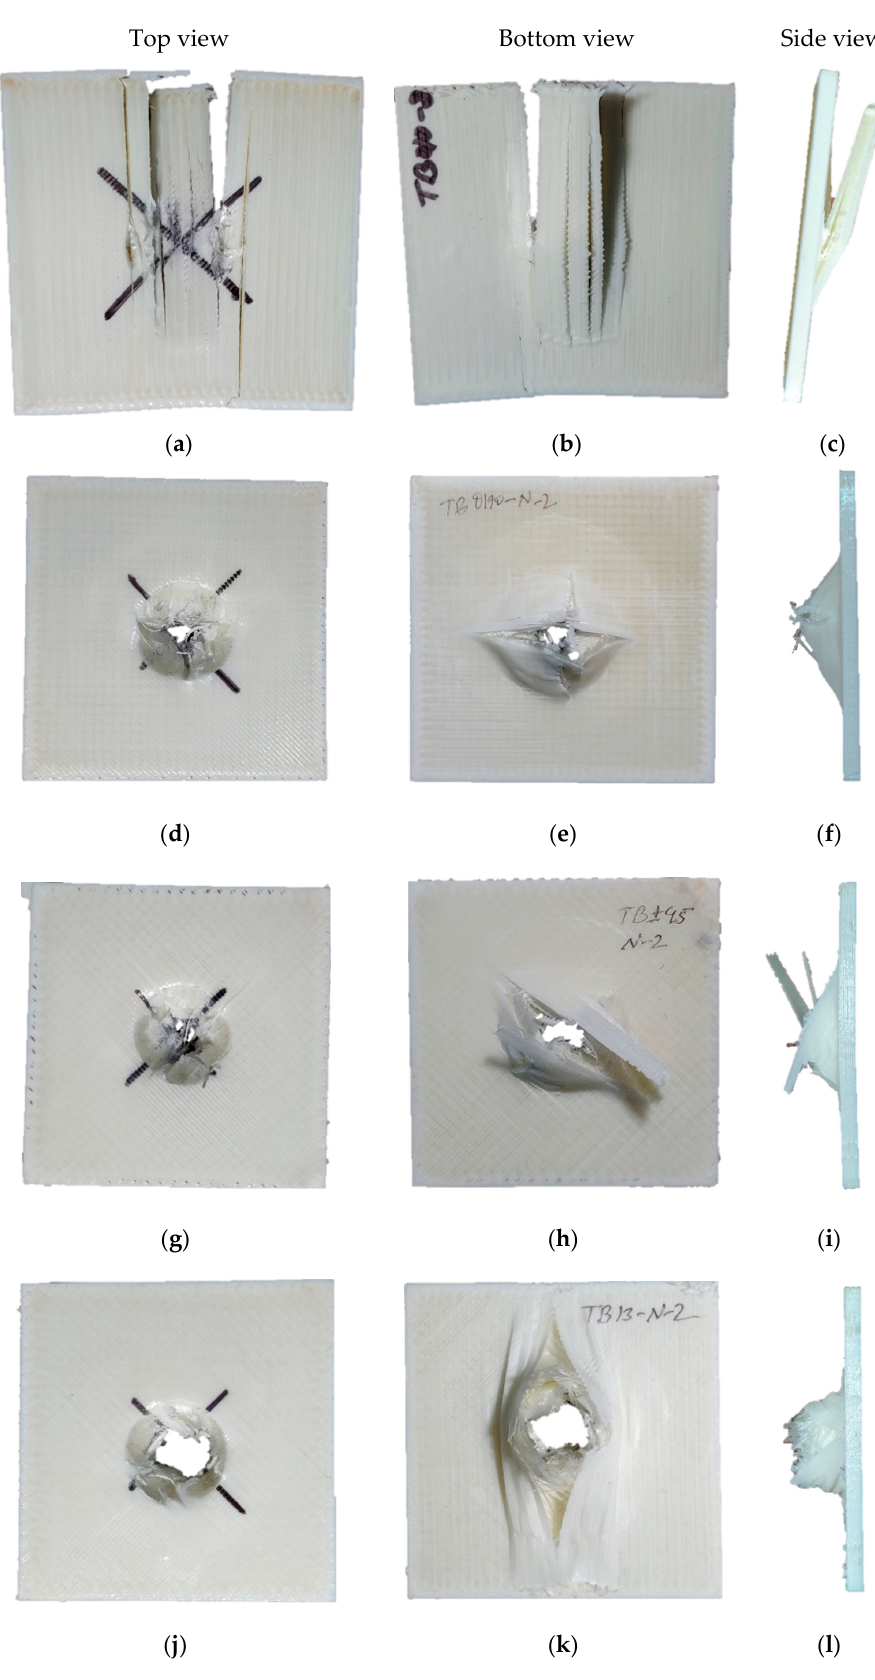
Figure 6. Fractography of Drop-weight impacted samples; top ( a , d , g , j ), bottom ( b , e , h , k ), and side ( c , f , i , l ) views of unidirectional, cross-lay, angle-lay and quasi-isotropic composites.